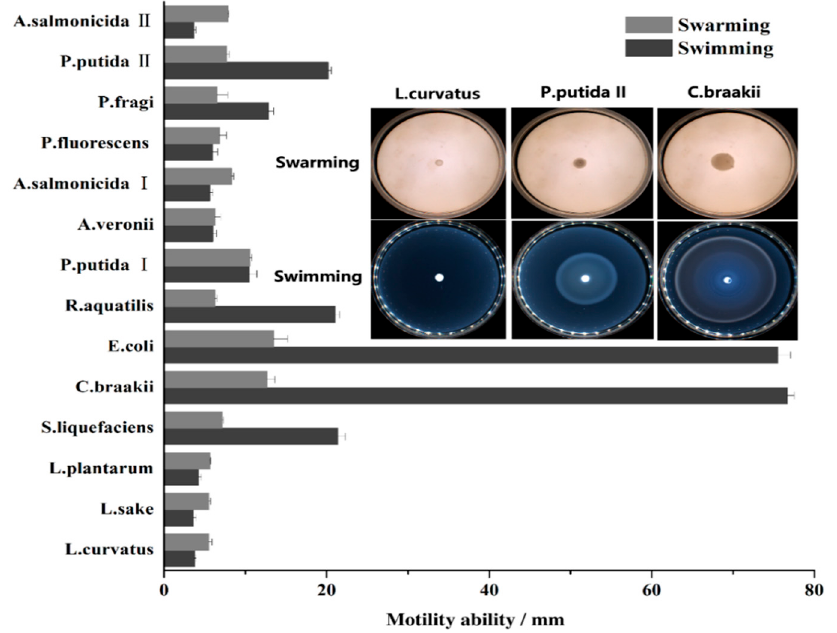
Figure 2. Motility ability evaluated by diffusion circle diameter (mm) of the 14 individual strains. Error bars represent standard deviations of the mean ( n = 6). Colony patterns formed by C. braakii , P. putida II and L. curvatu were shown as representatives.